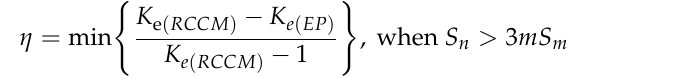
Table 3. Results of K e under thermal load of Z2CND18.12 (nitrogen control) for nozzle model. Node